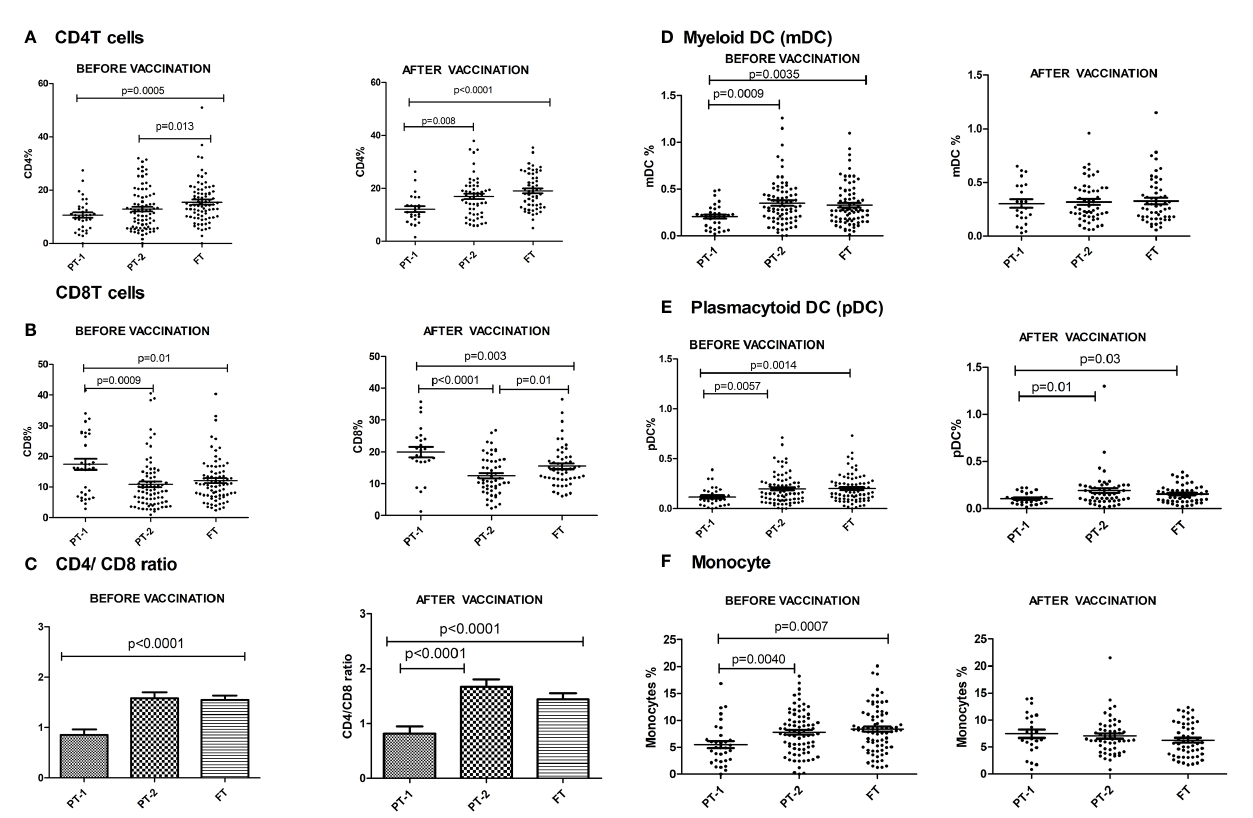
FIGURE 5 | Frequency of major Immune cells in PT1, PT2 and FT infant groups prior to (at baseline) and one month post-pentavalent vaccination. The vertical scatter dot plots represent frequencies of different immune cells before and after pentavalent vaccination: (A) CD4 T cells, (B) CD8 T cells, (C) CD4/CD8 T cell ratio (D) Myeloid dendritic cells, (E) Plasmacytoid Dendritic Cells and (F) monocytes. Error bars- Mean with